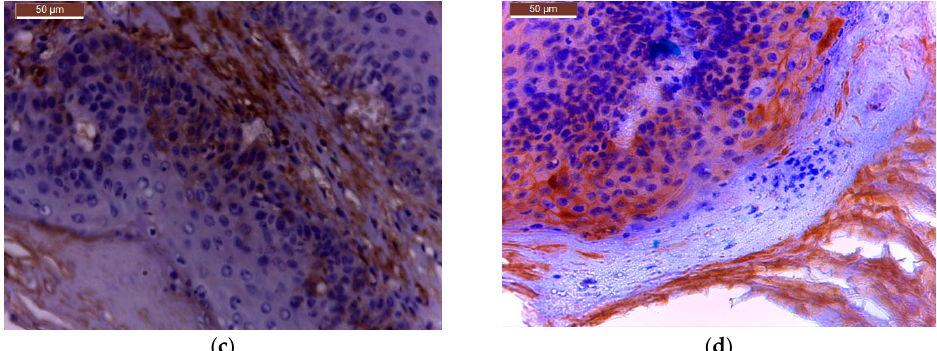
Figure 6. Bcl-2 expression in tumour sample treated with: ( a ) C_BCNU@HCLI; ( b ) cream BCNU; ( c ) base cream; ( d ) control saline. Quantitative levels of bcl-2 expression and inter-treatment comparisons for the tumour samples from all treated groups are presented in the following tables (Tables 4–6). Table 4. Bcl-2 expression level: quantitative intensity of the chromogen (diaminobenzidine, DAB) expressed as EU/pixel (Energy Units/pixel) of the new formulation and the control type treatments; (TIFFalyzer); standard error (SE).